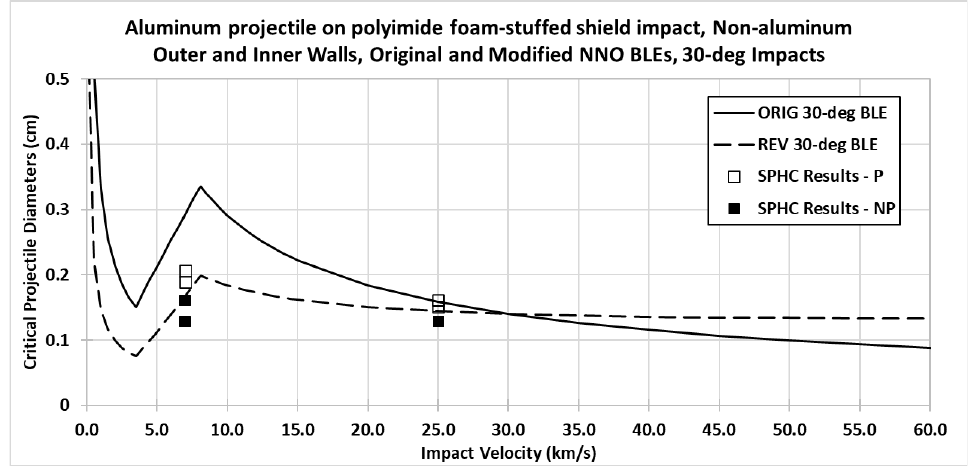
Figure 6. Comparison of Original and Modified NNO BLEs against P/NP data in [12] for Dual-Wall Systems with Non-Aluminum Outer and Inner Walls.